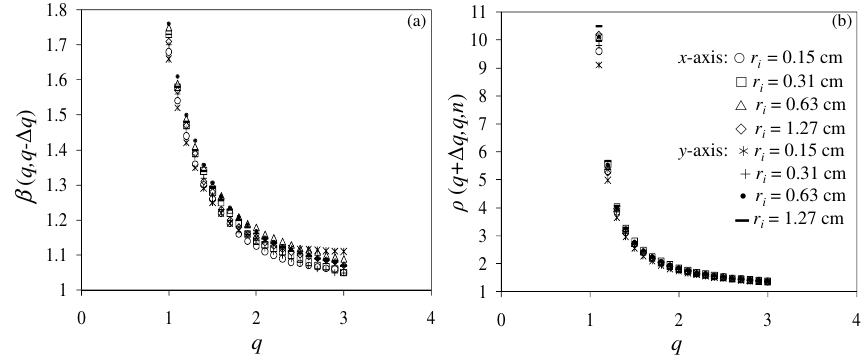
Fig. 9. (a) β(q , q − 1q) and (b) ρ(q + 1q , q , n =0.5) versus q evaluated on face 1 in x and y directions and various r i .